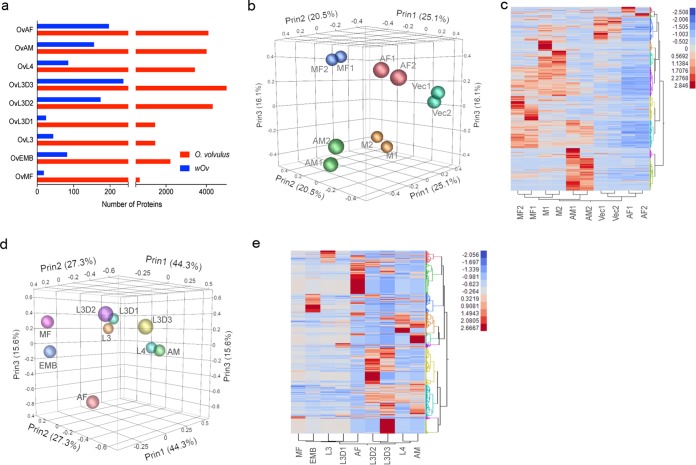
Overview of the transcriptome and proteome of O. volvulus. (a) Numbers of O. volvulus-specific (red) and Wolbachia-specific (blue) proteins identified across the stages by proteomic analyses. (b) Three-dimensional principal-component analysis plots highlighting the transcriptomic signatures of adult males (AM), adult females (AF), mf (MF), vector stages (Vec), and molting (M). (c) Heat map illustrating the hierarchical clustering of the normalized expression of transcripts of the stages in panel b. (d) Three-dimensional principal-component analysis plot highlighting the stage-specific proteomic signatures in adult females (AF), adult males (AM), embryos (EMB), mf, the L2 larval stage, the L3 larval stage, L3 larvae cultured in vitro for 1 to 3 days (L3D1, L3D2, and L3D3), and in vitro-developed L4 larvae (e). Heat map illustrating the hierarchical clustering of the normalized protein abundance in the stages analyzed in panel d.